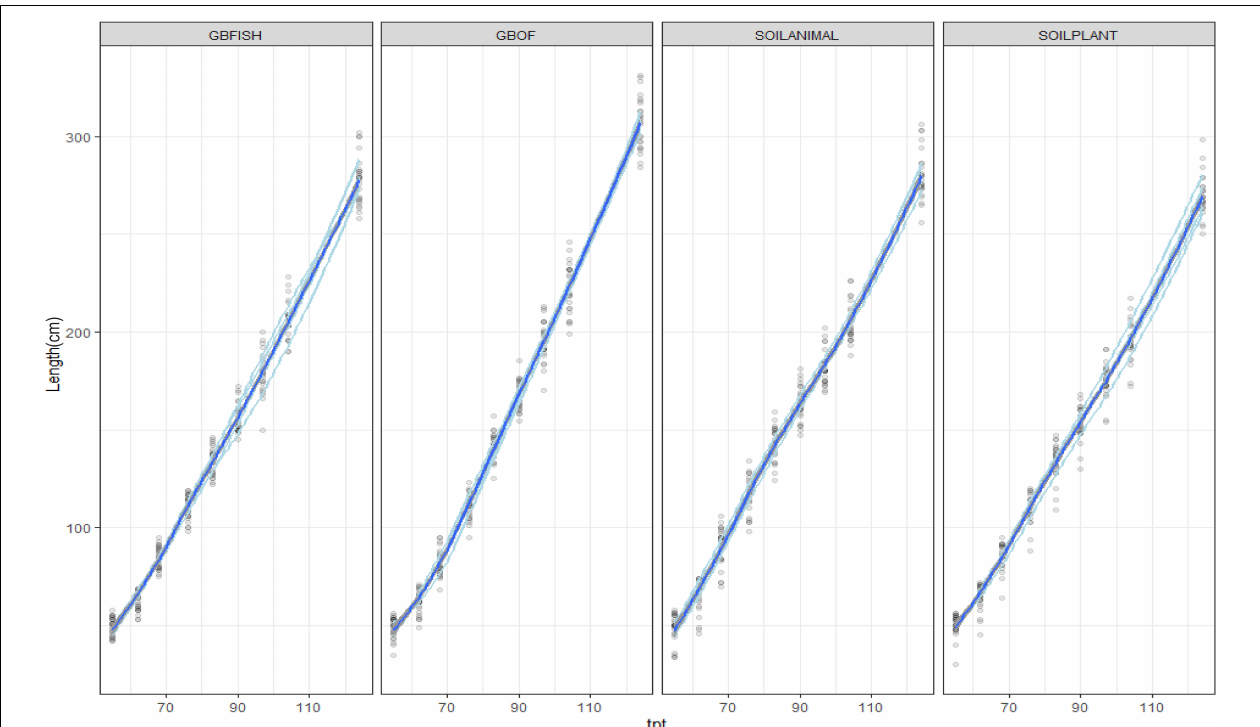
FIGURE 2 | Evolution of the plant length (cm) from 55 DAS till 125 DAS in the growing medium. i.e., GBOF and GBFISH and the organic soil. i.e., SOILANIMAL and SOILPLANT. The graph shows the 95% confidence interval, which was plotted around the dark blue line. The light blue lines are the values of the different experimental